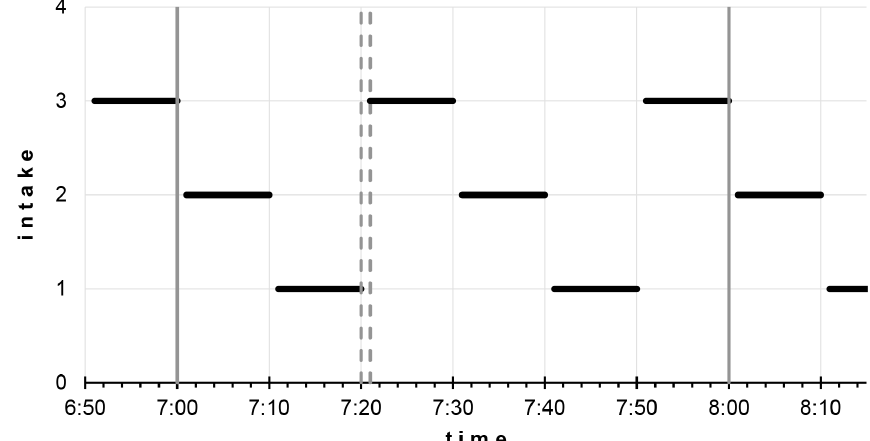
Figure 1. Schematic of an example measurement protocol with three intakes and 600s sampling time, providing two complete cycles within an hour. Vertical dashed lines represent the 1min flush time after switching the intakes and before the signal integration. The signal integration period is indicated by thick black line